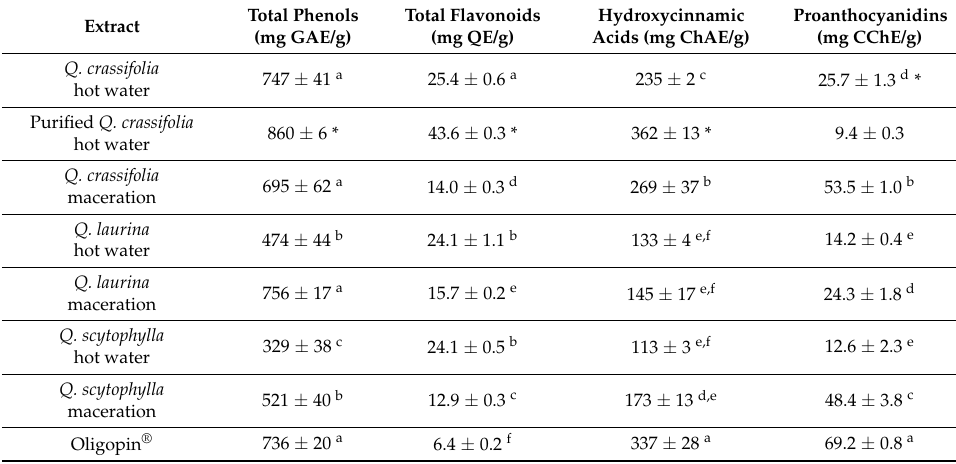
Table 2. Total phenol, total flavonoid, total hydroxycinnamic acid, and proanthocyanidin content of Mexican Quercus species extracts obtained by hot water and maceration